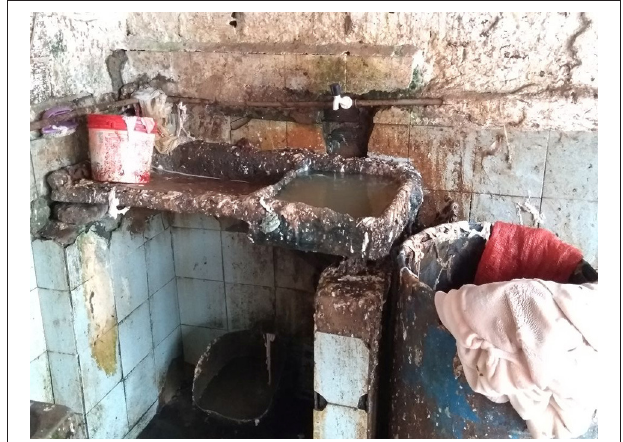
FIGURE 1 | Absence of quality-control programs of a clandestine bovine slaughter, showing a disorganized, and dirty production (24).